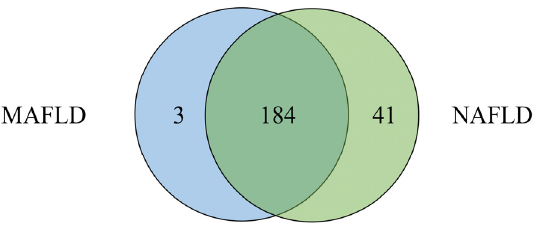
Figure 3. Composition of MAFLD and NAFLD in NHANES 2017–2018. The blue circle indicates participants with metabolic-associated fatty liver disease (MAFLD), and the green circle indicates participants with nonalcoholic fatty liver disease (NAFLD); the middle overlapping part indicates participants with both MAFLD and NAFLD.